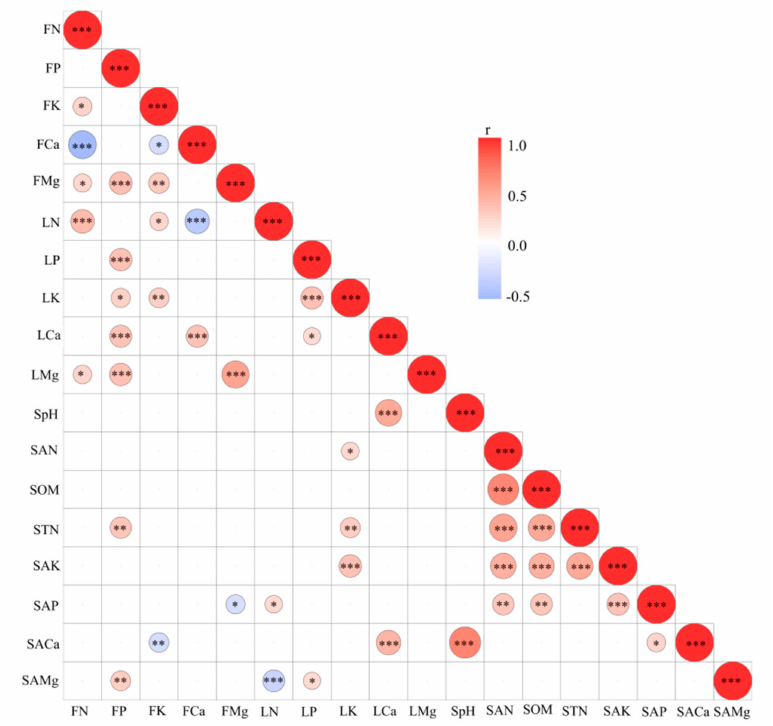
Figure 13. Spearman correlation heat map showing correlations among nutrient concentrations in fruit flesh, leaf and soil in 100 mango orchards. F: flesh, L: leaf, S: soil. Only significant values ( p < 0.05) are shown. Red and blue colors represent significant positive correlations and negative correlations. Darker color represents stronger correlations. *, p < 0.05; **, p < 0.01; ***, p <